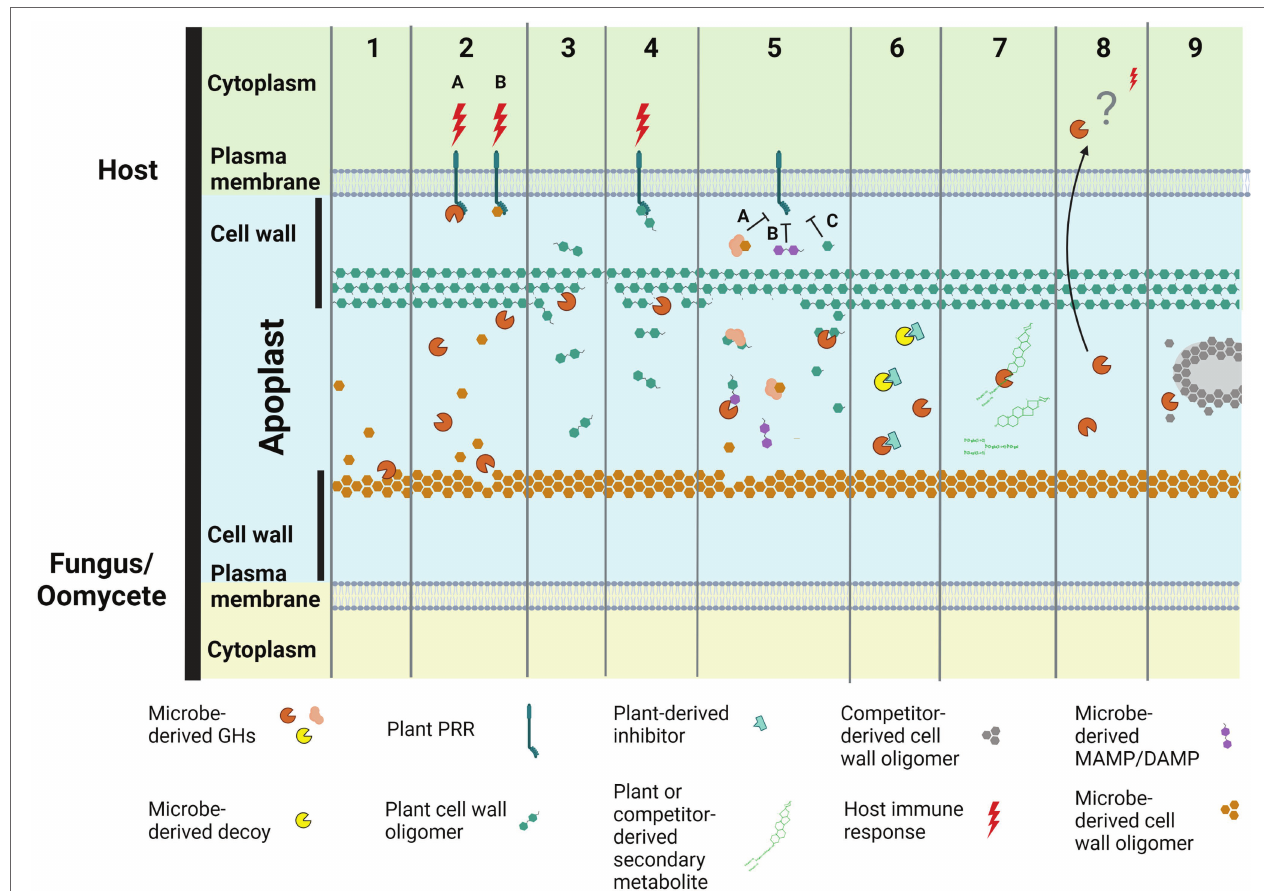
FIGURE 1 | Secreted glycoside hydrolase (GH) proteins from plant-associated fungi and oomycetes play diverse roles in promoting plant colonization and/or activating plant immune responses. These roles include: (1) the modification of surface-associated carbohydrates present in their own cell walls to enable the remodeling of hyphal surfaces or infection structures produced during plant colonization; (2) the induction of plant immune responses, such as plant cell death, following their recognition as microbe-associated molecular patterns (MAMPs; 2A ), or the recognition of cell wall carbohydrate fragments (e.g., chitin or β -glucan oligomers) released from their own cell walls as a consequence of their activity [e.g. in (1) ; 2B ], by pattern recognition receptors (PRRs) at the plant cell surface to provide plant resistance or susceptibility. Regarding the latter, plant cell death could, for example, result in a release of nutrients to support the growth of fungal or oomycete pathogens with a necrotrophic lifestyle, or drive a switch from biotrophy to necrotrophy for fungal or oomycete pathogens with a hemibiotrophic lifestyle; (3) nutrient acquisition through the release of carbohydrate fragments from plant cell walls or the breakdown of entire plant cells; (4) the induction of plant immune responses, such as cell death, following the recognition of plant cell wall carbohydrate fragments, generated as a consequence of their activity [e.g., in (3) ] by PRRs at the plant cell surface to provide plant resistance or susceptibility. Again, plant cell death could support necrotrophy (as in 2B ); (5) the sequestration (5A) , modification (5B) or degradation (5C) of MAMPs or DAMPs to prevent their recognition by PRRs at the plant cell surface to prevent activation of plant immune responses; (6) acting as a decoy to bind host-produced proteins that would otherwise inhibit GH proteins produced by plant-associated fungi or oomycetes; (7) the